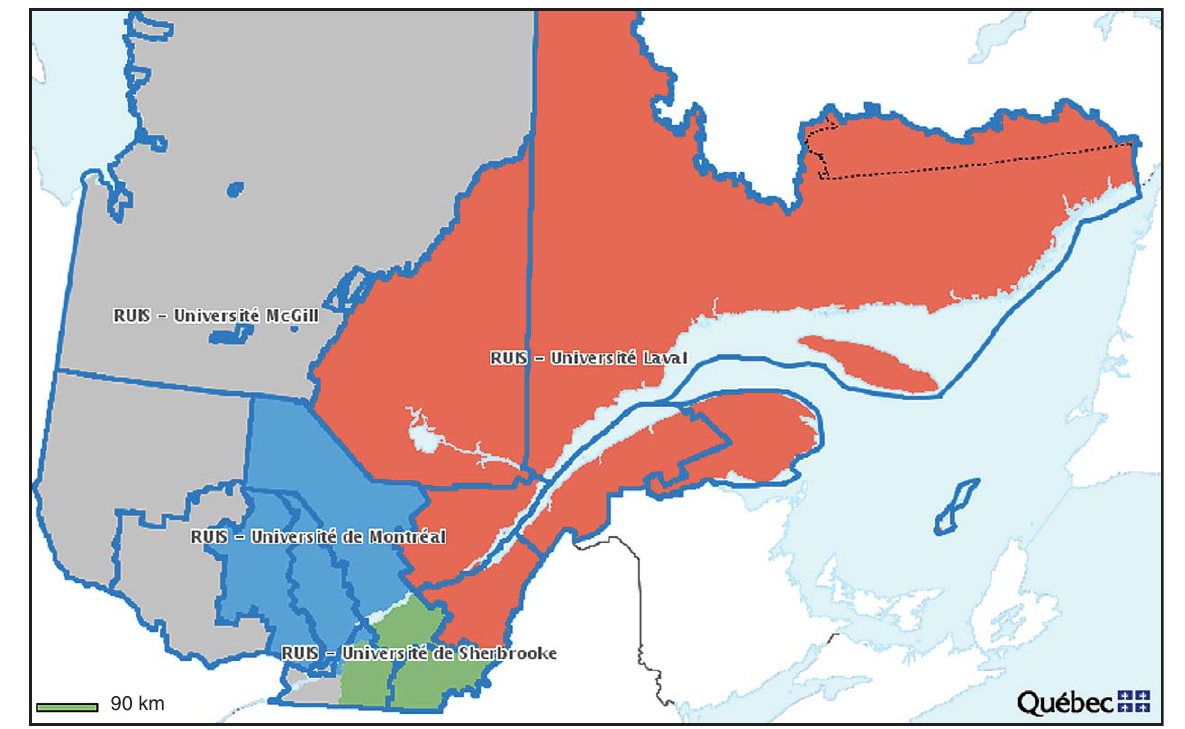
Fig. 1. Geographic distribution of the 4 RUIS in Qu´ebec. The region identified “RUIS – Universit´e Laval” is covered by the Eastern Qu´ebec Telepathology Network. (Reproduction authorized by the “minist`ere de la Sant´e et des Services sociaux, © Gouvernement du Qu´ebec, 2011”.)